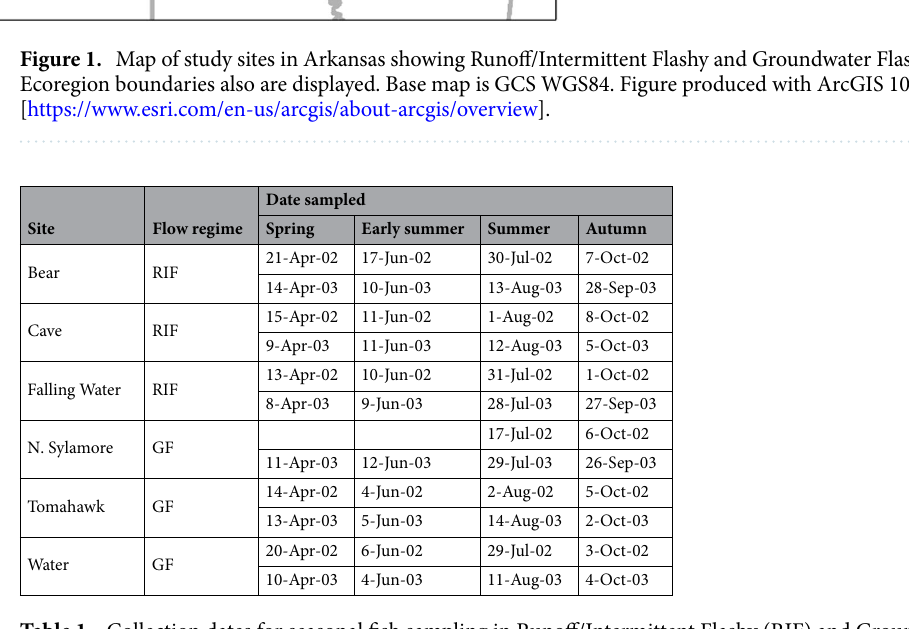
Table 1. Collection dates for seasonal fish sampling in Runoff/Intermittent Flashy (RIF) and Groundwater Flashy (GF) streams in 2002 and